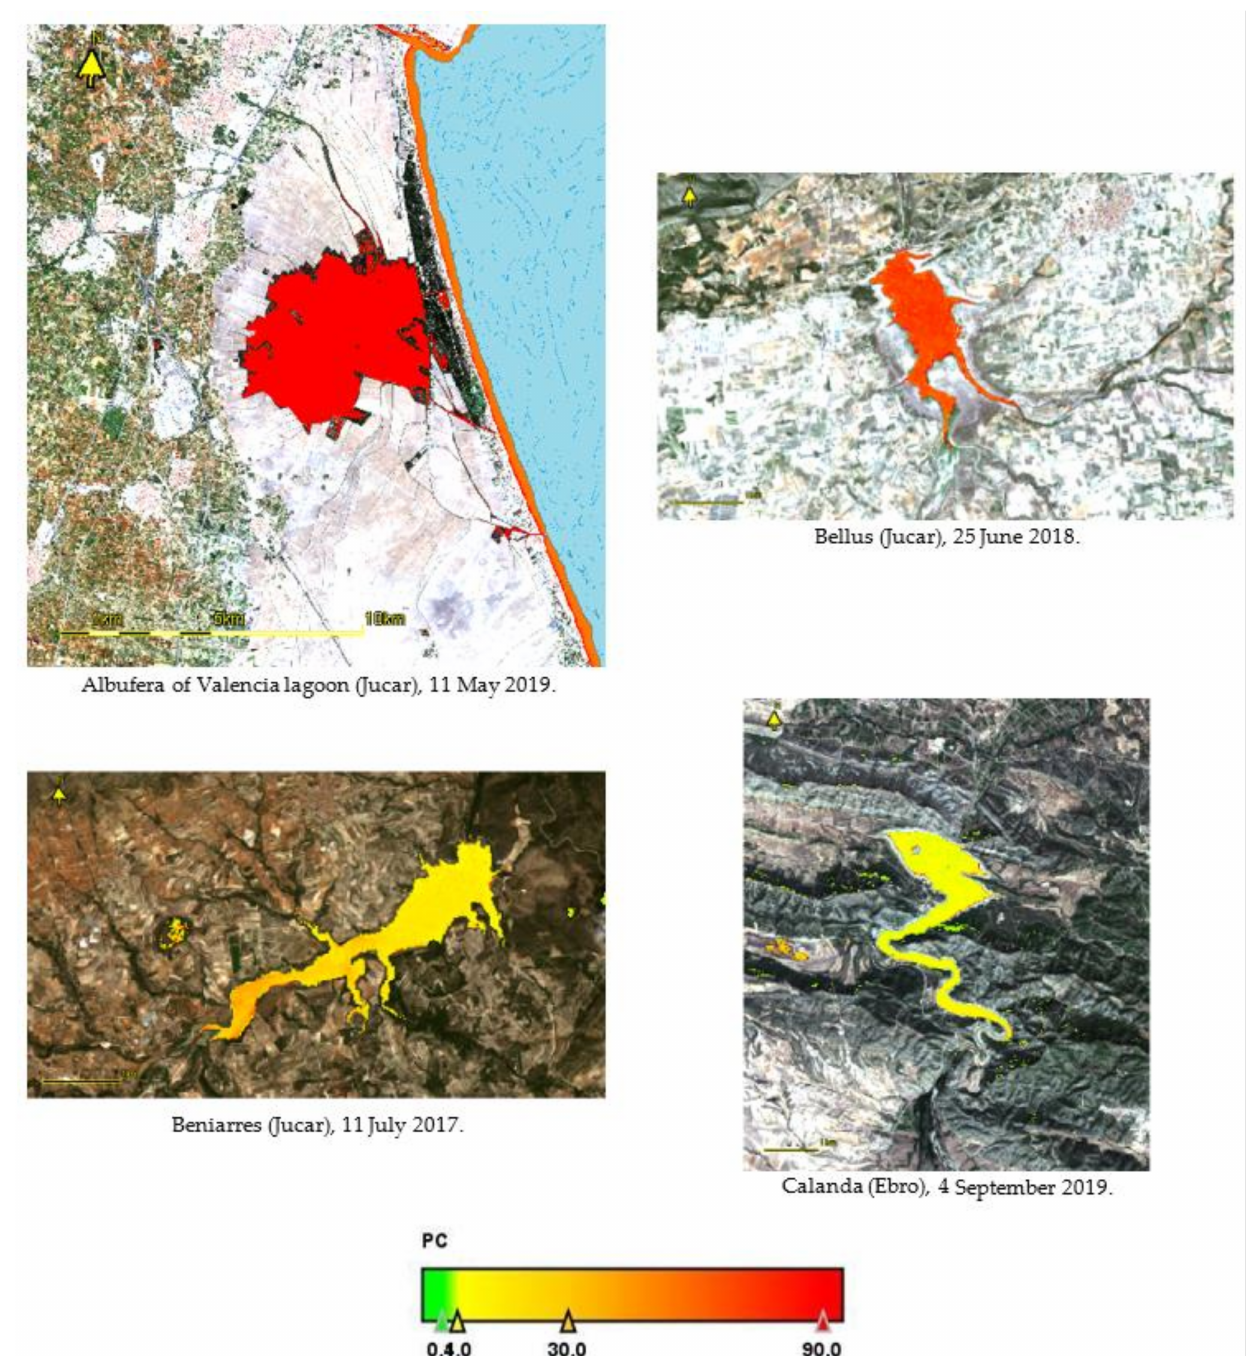
Figure A1. Thematic maps of PC ( µ g L − 1 ) in some reservoirs, showing the alert level in a color scale according to Table 3. For each site, the date of the image and the watersheds are